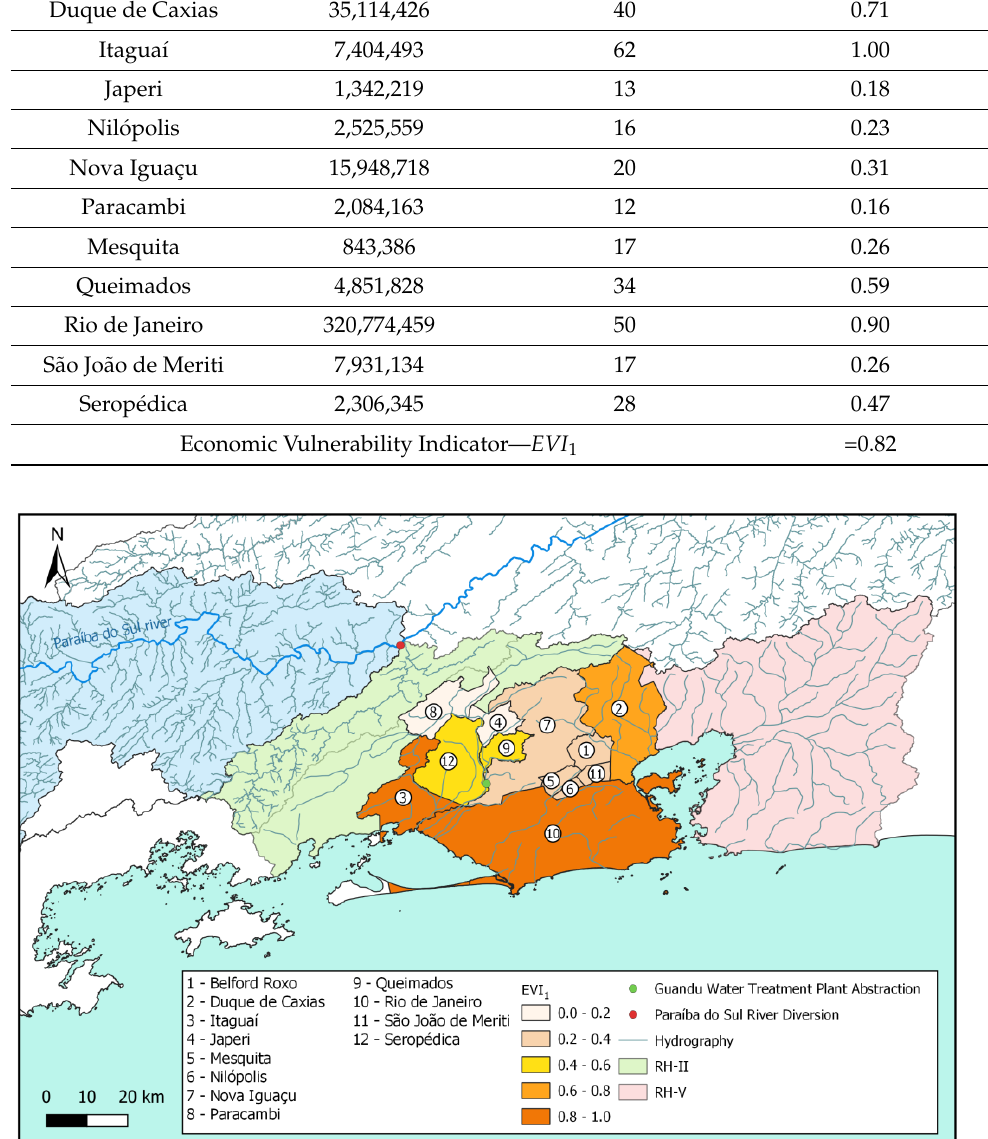
Table 18. Economic vulnerability indicator ( EVI 1 ) application.